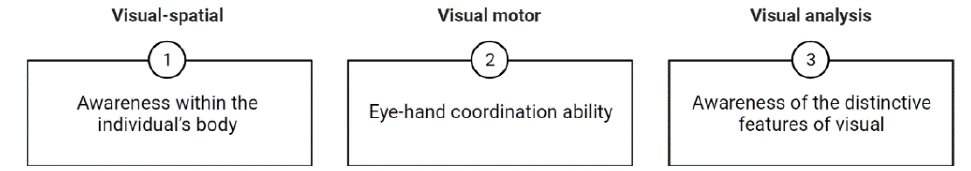
Figure 4. Visual information processing skills required for awareness and eye–hand coordination.